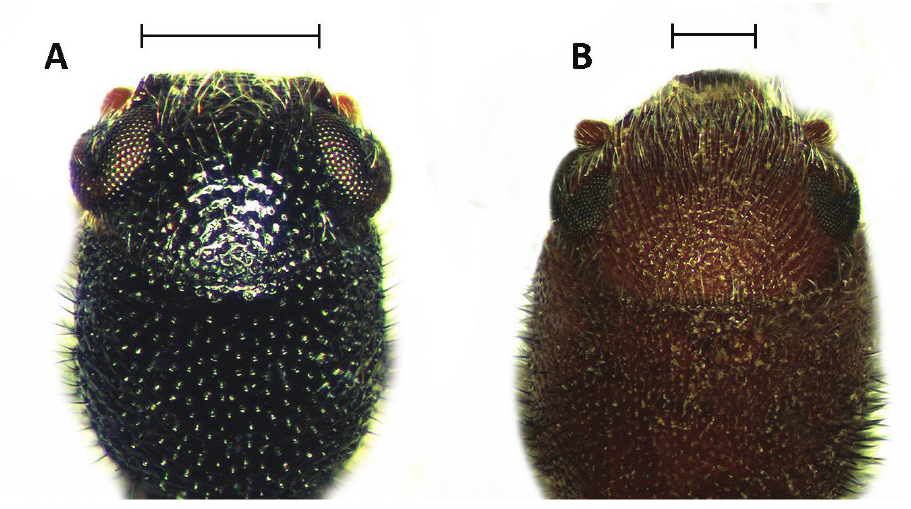
Figure 6. Head of: A Neocallotillus elegans ( Callotillus elegans elegans ) B Callotillus eburneocinctus . Scale bars indicate width of